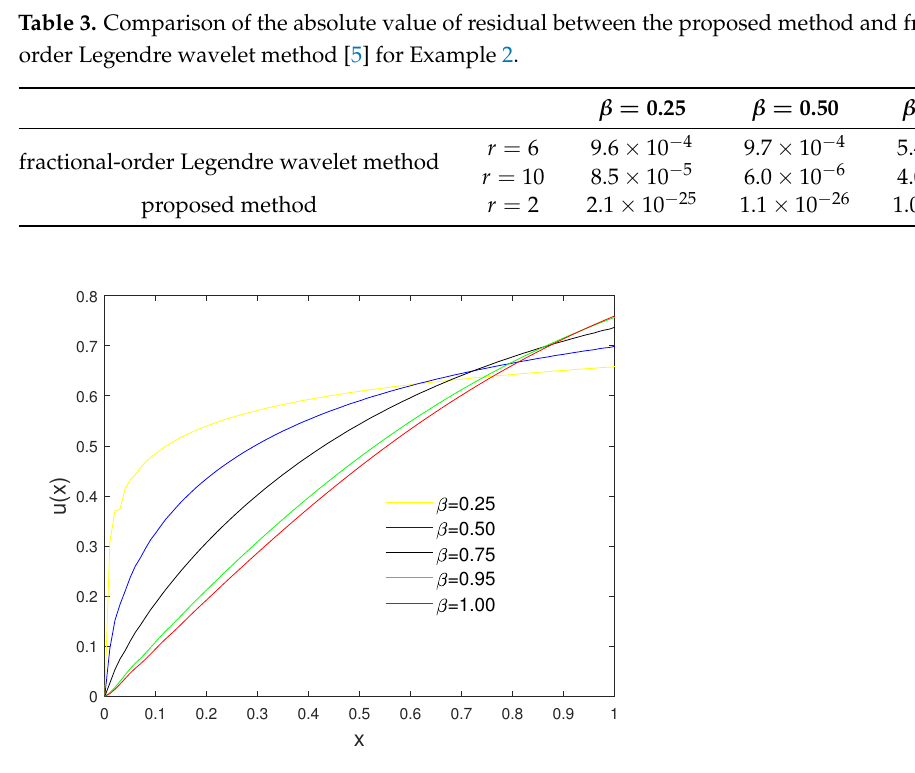
Figure 3. The approximate solution, taking s = 4 and different values of β , for Example